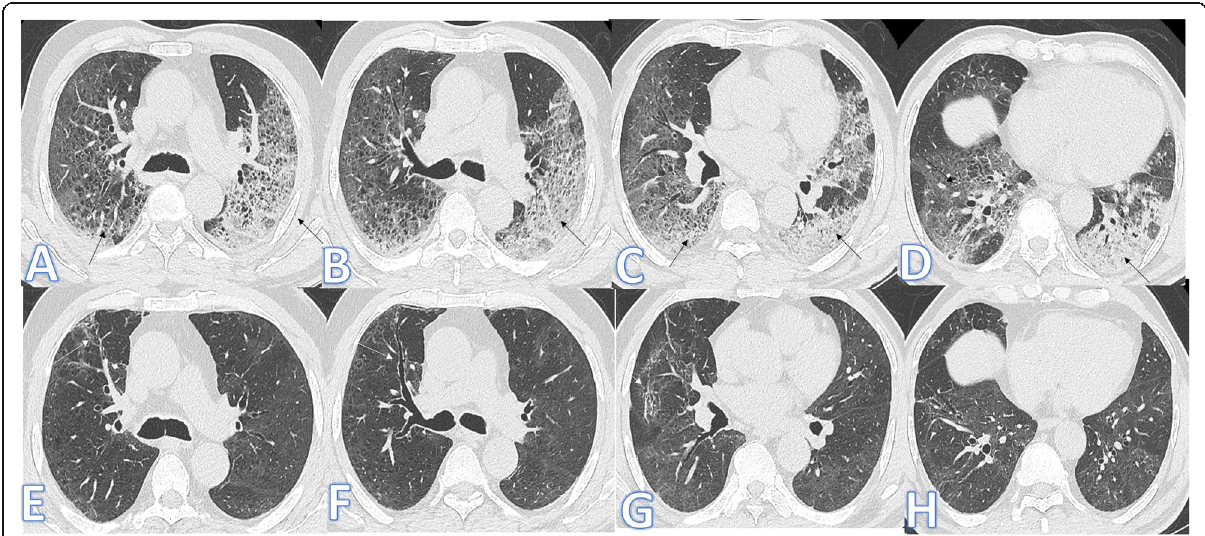
Fig. 4 Sixty-four-year-old male: he has DM and HTN; peak CT severity score 17; consolidation/crazy-paving score 11. No ICU admission; laboratory results showed lymphopenia, high CRP, D -dimer, and serum ferritin. Steroid was given; length of stay during hospitalization is 20 days. Peak CT ( a – d ) showed GGO with interstitial thickening giving a crazy-paving appearance (arrows). Follow-up CT 45days after discharge ( e – h ) showed almost resolution of the previous with residual fibrosis with parenchymal bands, coarse reticular pattern, and mild traction bronchiectasis at the anterior segment of the right upper lobe and lateral segment of the right middle lobe (arrows)